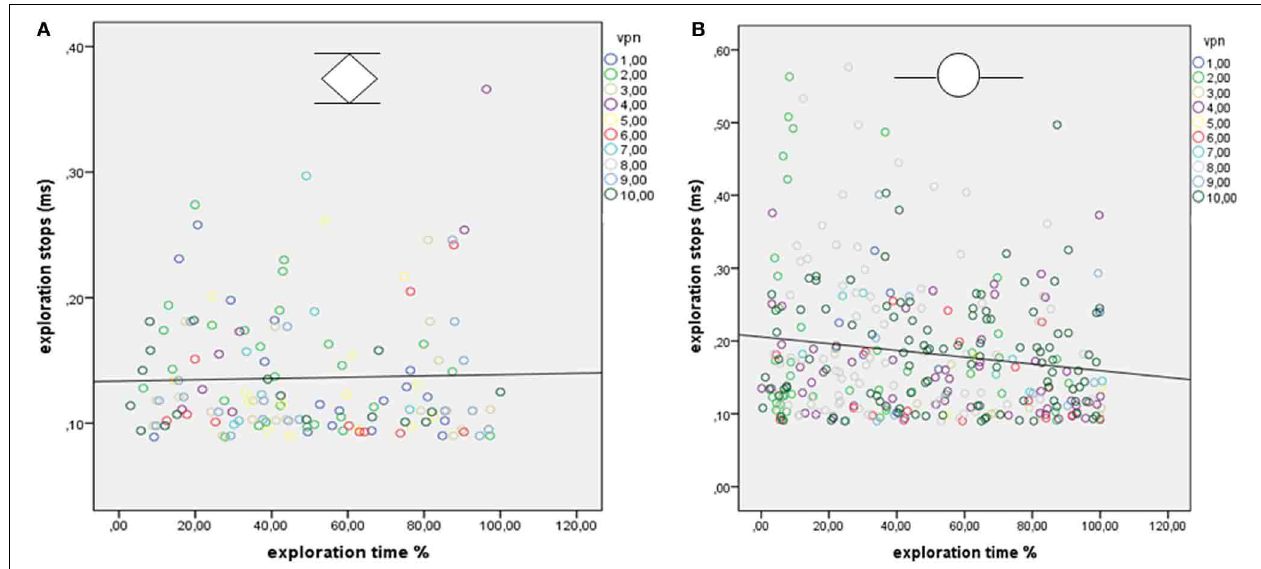
FIGURE 7 | (A,B) Regression plots show the relationship between relative exploration time and duration of explorative stops (ES) for one stimulus from experiment E [real sunken reliefs; 10 participants (VPN)] and (B) for one stimulus from Experiment D (virtual sunken reliefs, 10